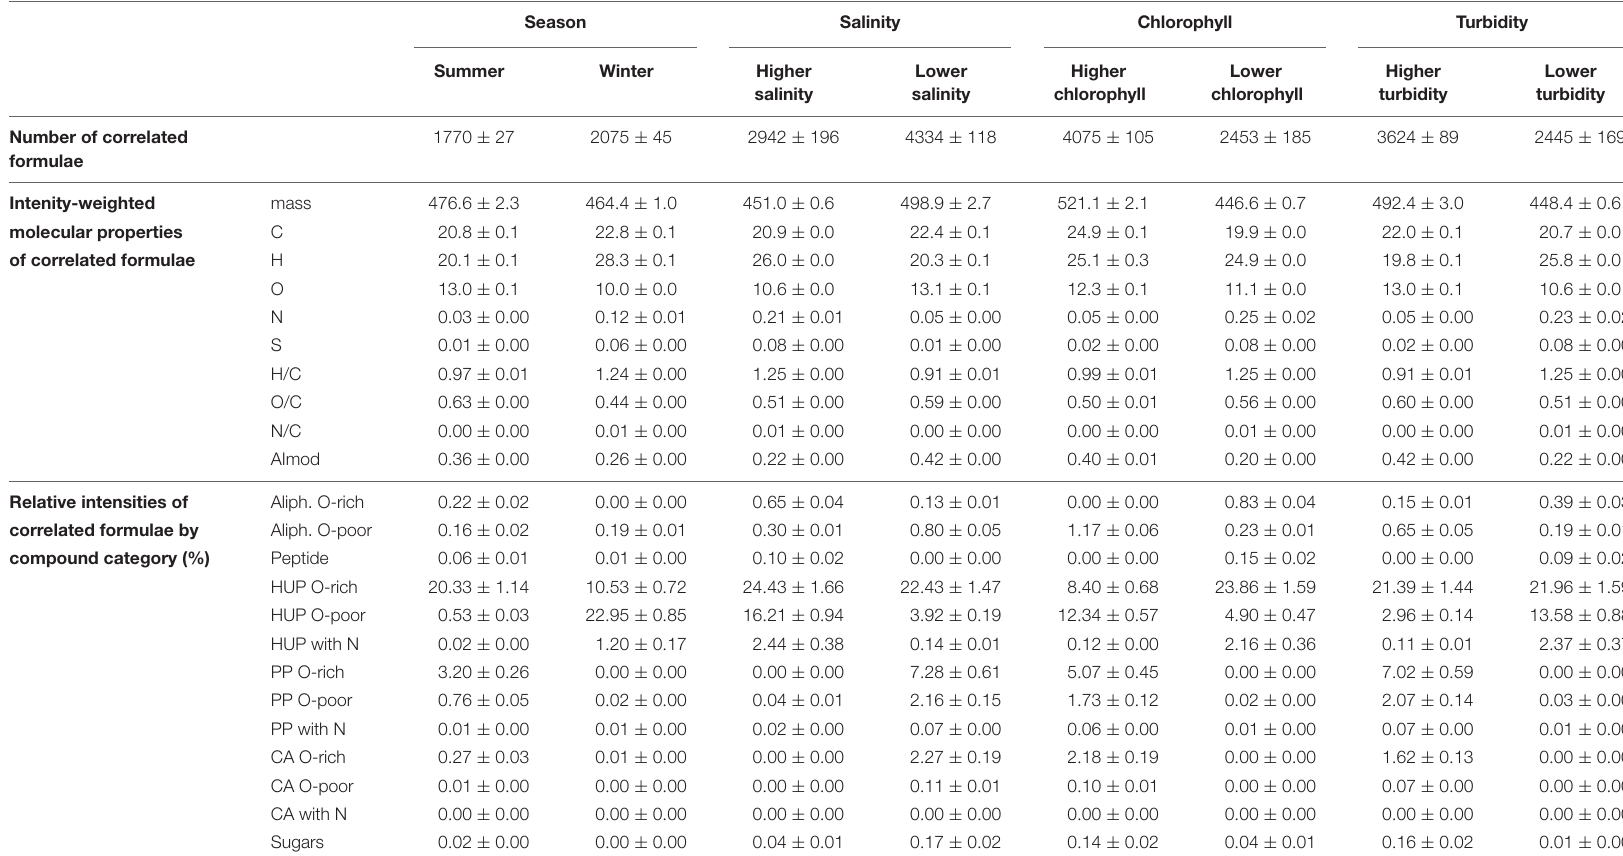
TABLE 2 | Characteristics of FT-ICR MS-derived formulae that are significantly correlated (Spearman rank, p -value < 0.028) with season and water column properties in Baker-Martinez